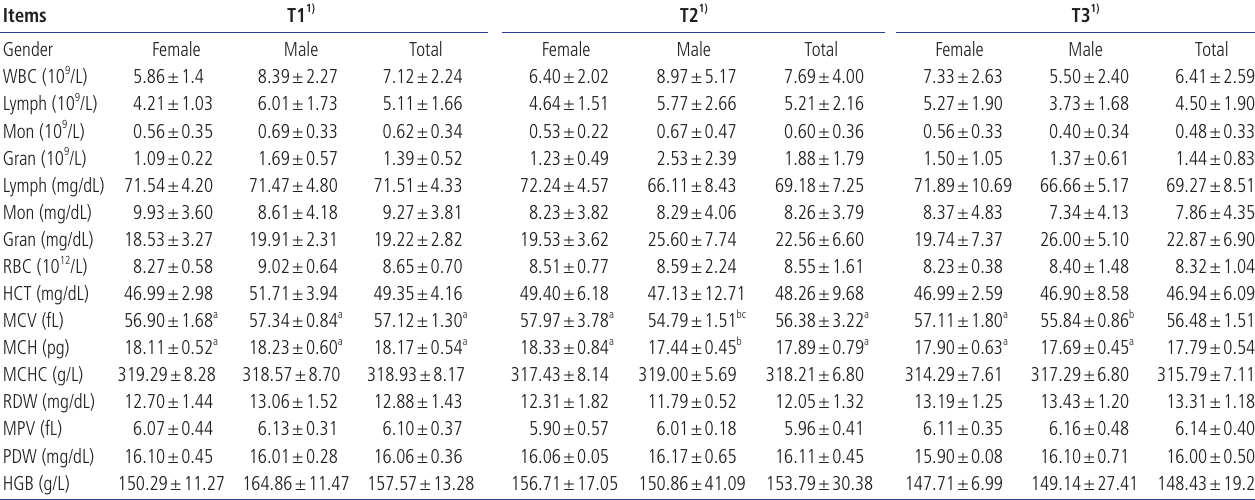
Table 2. Effect of mulberry leaves on hematological parameters of Sprague-Dawley rats at the end of the treatment period Items